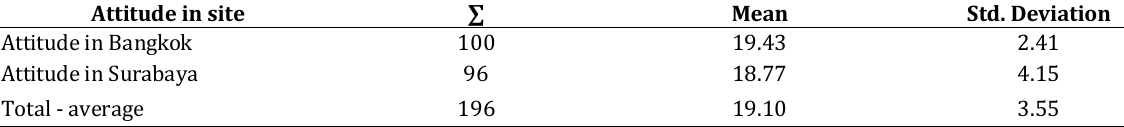
Total Table 6. Descriptive statistics of the elderly attitude towards MHE Attitude in site ∑ Mean Std. Deviation